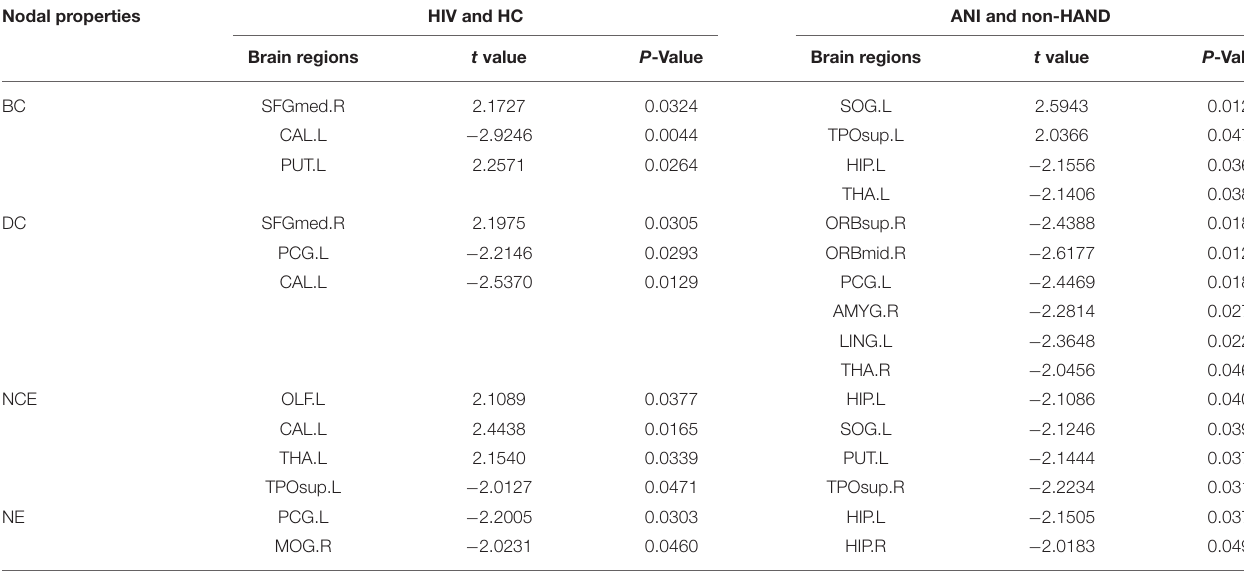
TABLE 2 | Comparison of structural network nodal properties in all nodes among HIV + patients and HC groups and ANI and non-HAND groups. Nodal